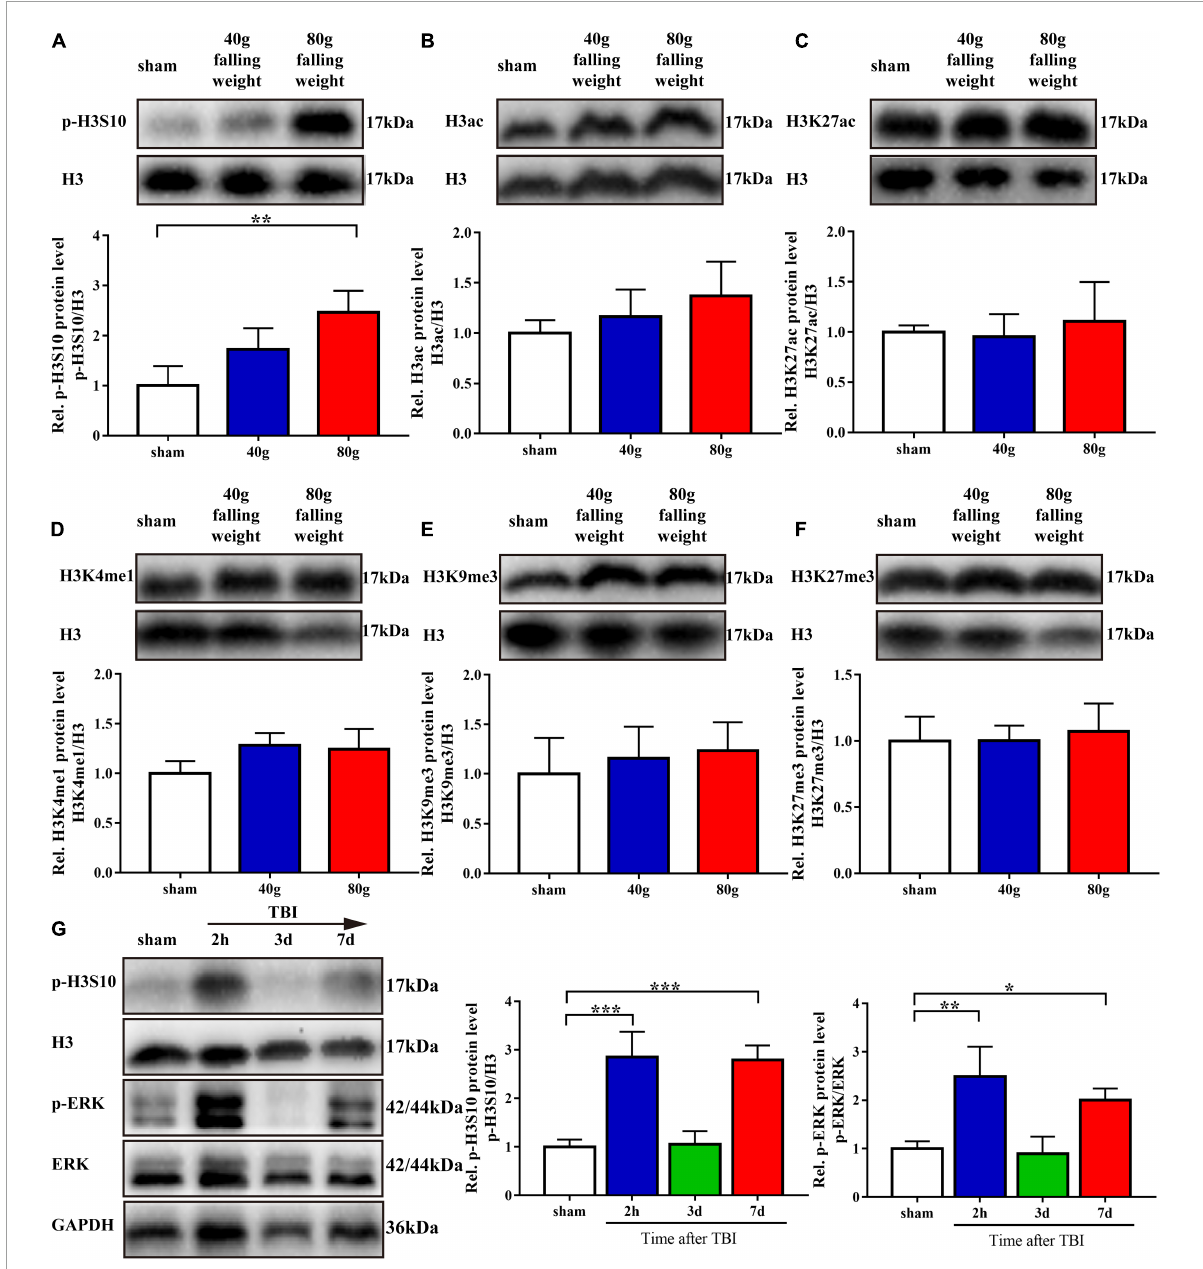
FIGURE2 Phosphorylation of histone H3 Ser10 was upregulated in TBI. The level of p-ERK showed variation trends similar to those of p-H3S10 at multiple time points. (A–F) Protein bands from western blots for p-H3S10, H3ac, H3K27ac, H3K4me1, H3K9me3, H3K27me3, and H3. The expression of each protein was normalized to that of H3. On the seventh day after TBI, the relative protein level of p-H3S10 showed a significant increase in the TBI rats compared with the sham rats, whereas no change was observed for H3ac, H3K27ac, H3K4me1, H3K9me3, or H3K27me3 ( n = 4 rats/group. One-way ANOVA followed by Holm-Sidak’s multiple comparisons test. * p < 0.05, ** p < 0.01, compared with sham. The values are expressed as the means ± SD). Measurement of p-H3S10 and p-ERK (G) levels at multiple time points showed increases at 2 h and on the seventh day after TBI ( n = 3 rats/group. One-way ANOVA followed by Holm-Sidak’s multiple comparisons test. * p < 0.05, ** p < 0.01, *** p < 0.001, compared with sham. The values are expressed as the means ± SD).